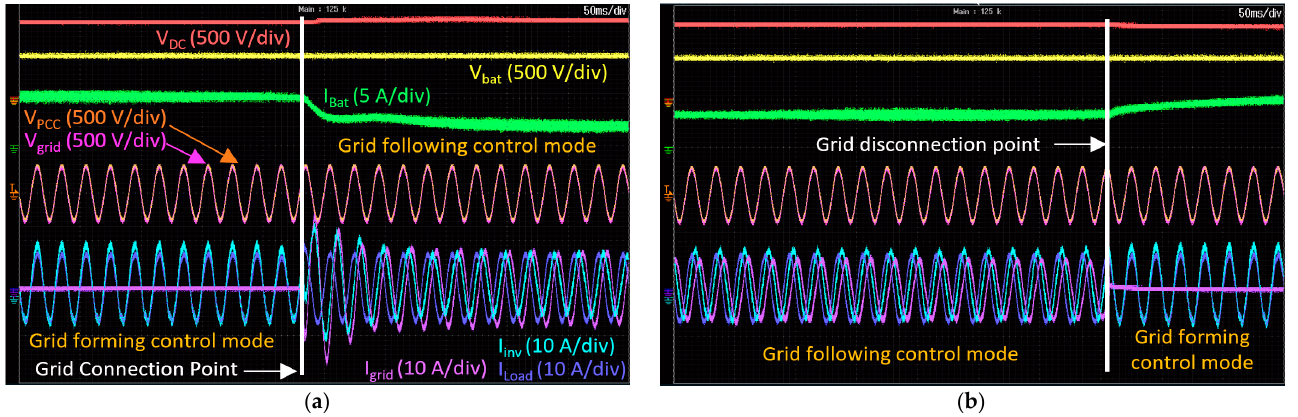
Figure 13. Experimental grid synchronization test for the designed EMS. ( a ): grid connection; ( b ): grid disconnection.